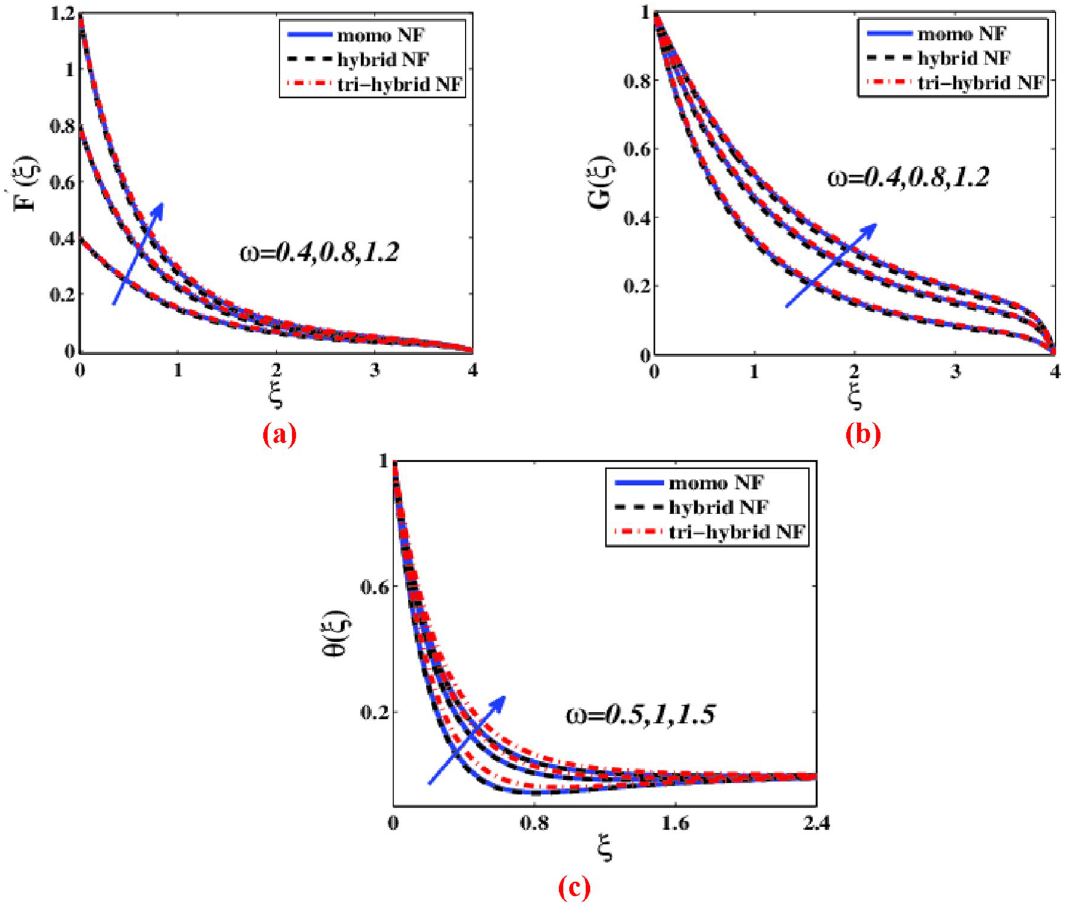
Figure 4. ( a ) F ′ (ξ) , ( b ) G (ξ) and ( c ) θ(ξ) with diverse ω